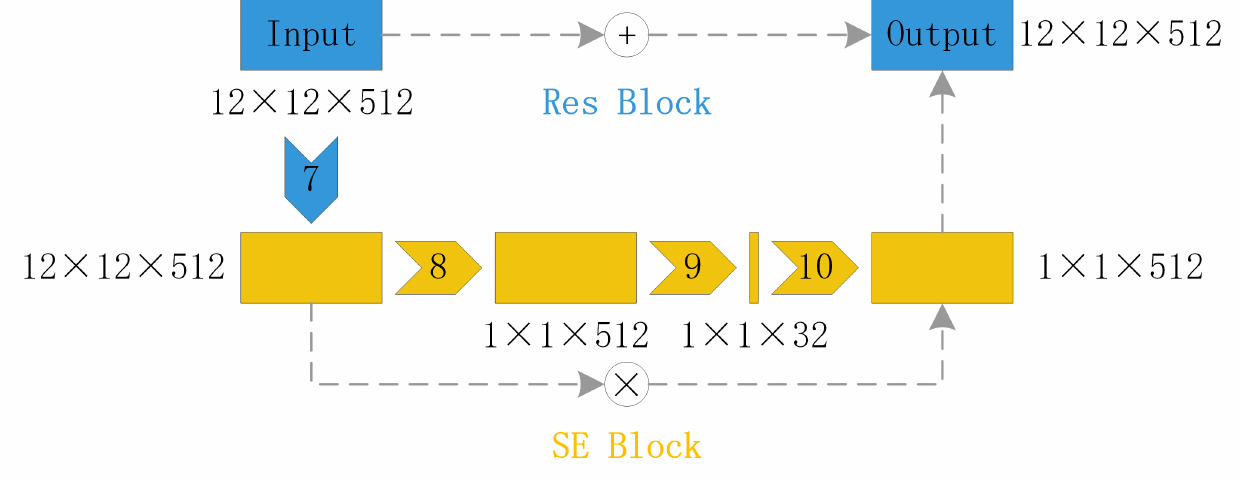
Figure 8. Res-SE block used in this